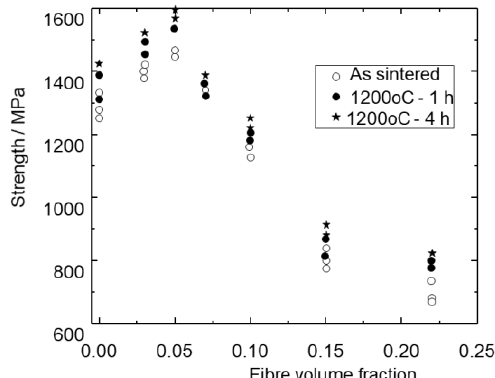
Figure 15. Bending strength of short carbon fibre and Ti – 6Al – 4V matrix composites versus the fibre volume fraction [55].